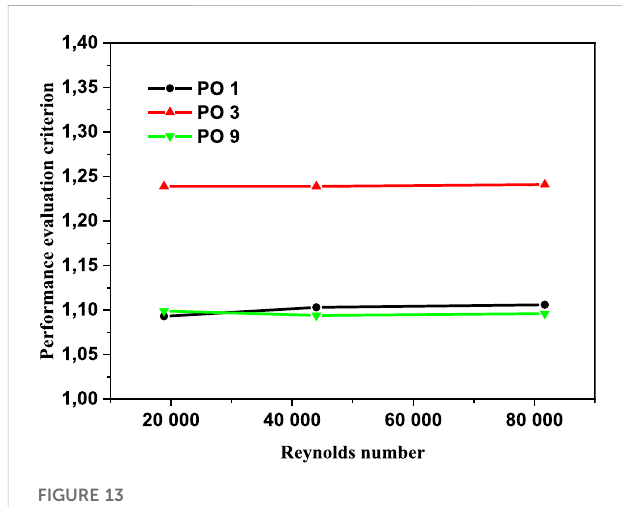
FIGURE 13 Performance evaluation criteria variation vs. Re